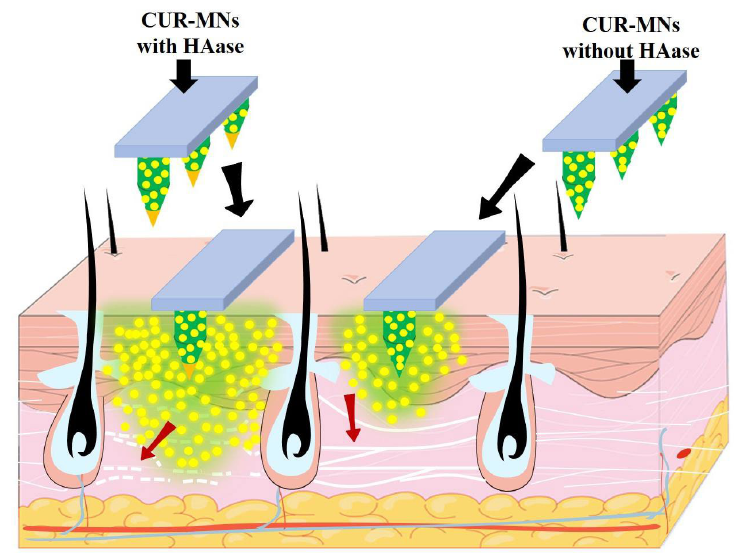
Figure 6. Mechanism of HAase enhancing intradermal diffusion of small-size CUR-NCs.